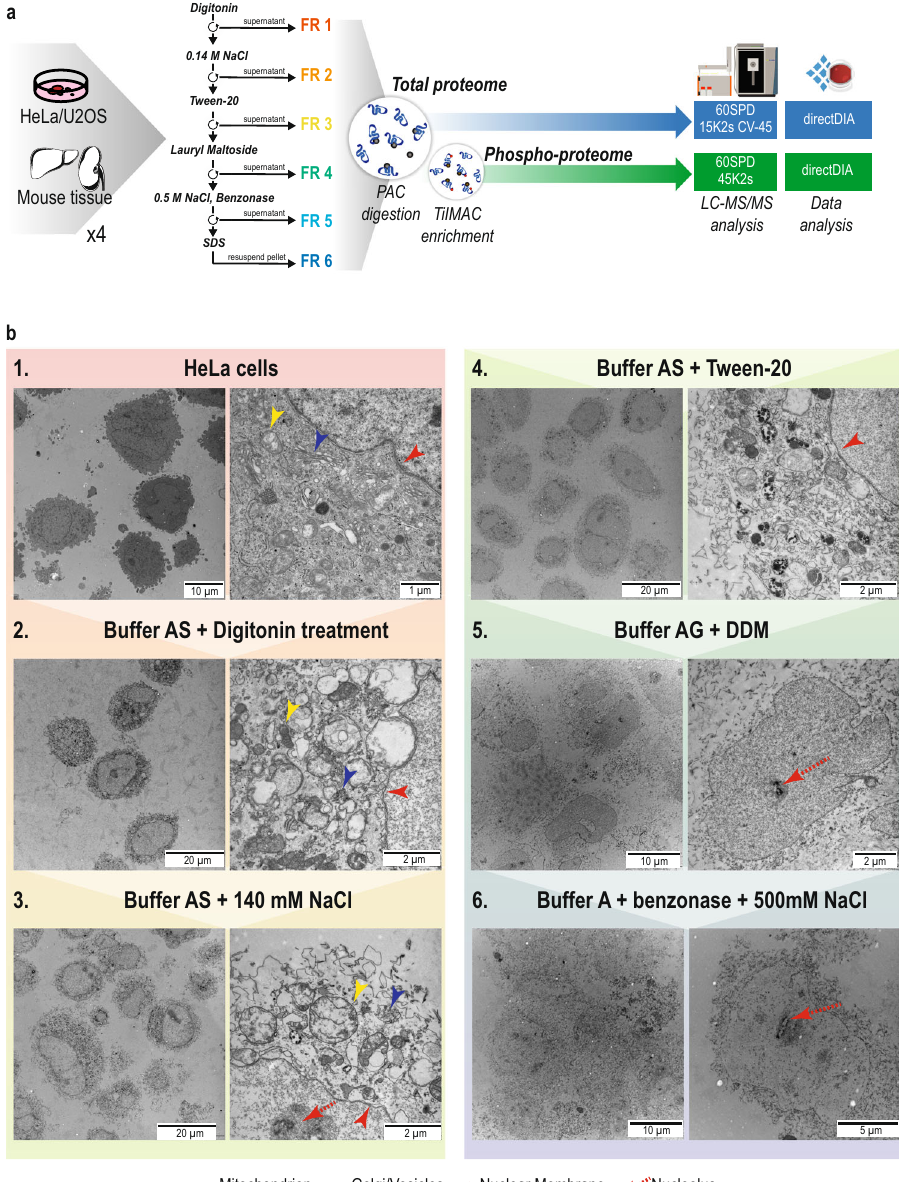
Fig. 1 High-throughput and reproducible subcellular fractionation. a Experimental work fl ow for subcellular fractionation and LC-MS/MS data acquisition. SPD: Samples Per Day, CV Compensation Voltage. b Transmission Electron Microscopy images from the different fractionation steps. 1: HeLa cells